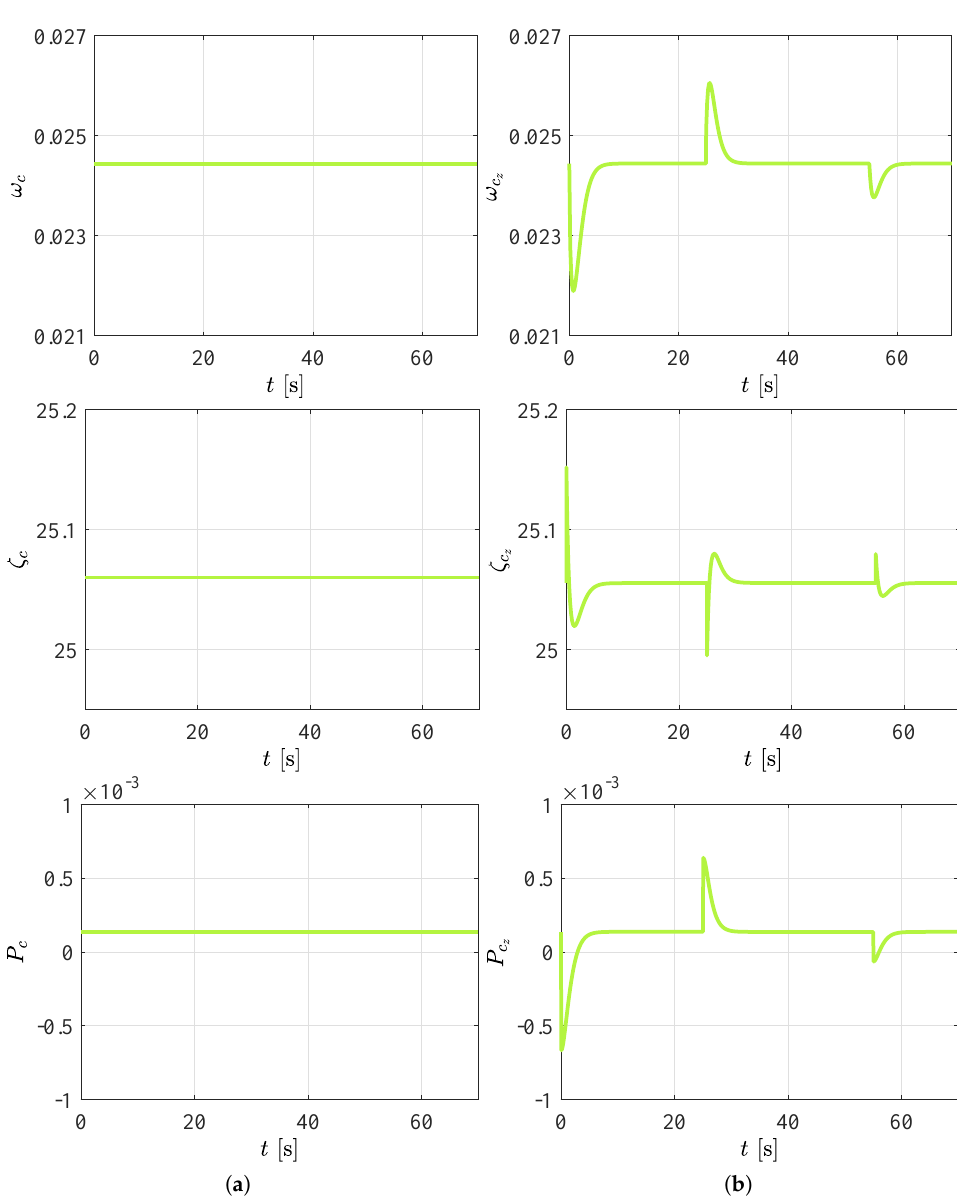
Figure 13. Fixed and adaptive control parameters used in experiment 3: ( a ) First scenario. ( b ) Second